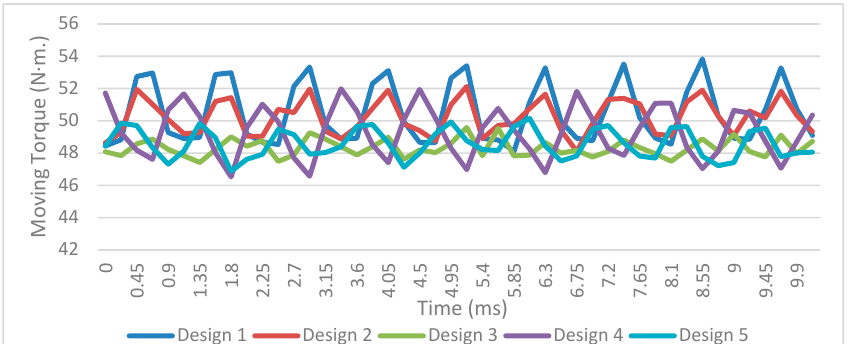
Figure 9. Electromagnetic torque results.